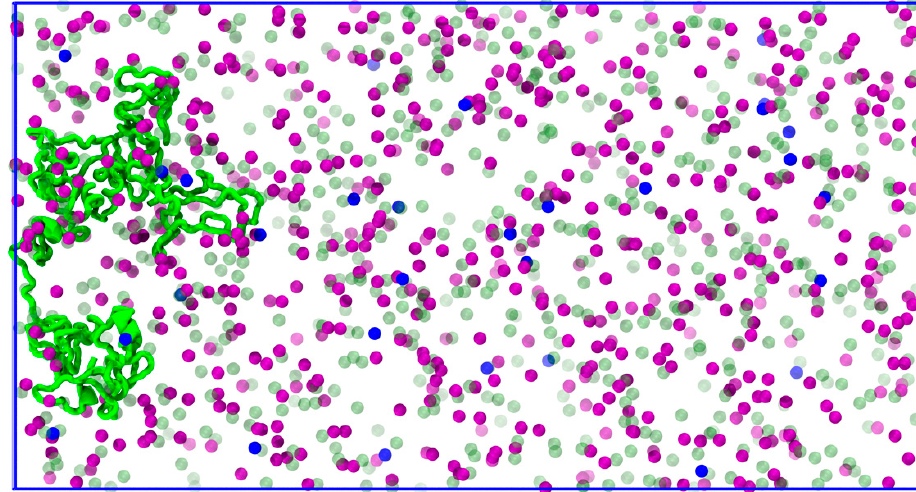
Figure 10. Orthographic view of constrained tau to the box wall. Tau is represented in green cartoon, K + in purple, Na + in blue, and Cl − in green transparent spheres.